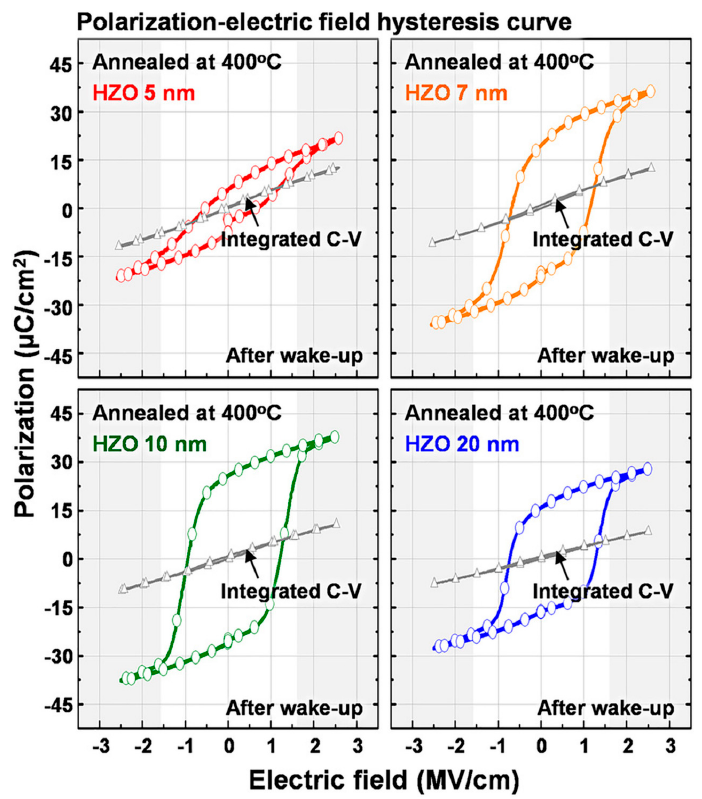
Figure 7. Polarization-electric field hysteresis and integrated capacitance voltage hysteresis curves of 5-, 7-, 10-, and 20-nm-thick HZO-based metal–insulator–metal (MIM) capacitors after wake-up field cycling (Reproduced with permission from [35]; AIP Publishing, 2018).